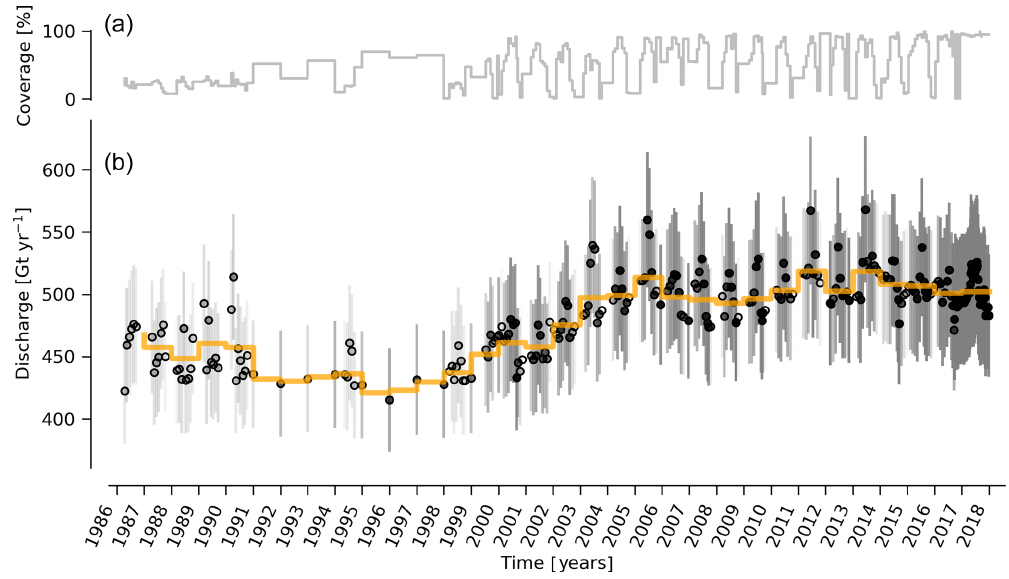
Figure A3. Same as Fig. 4 but without the velocity filter. Note the different y axis.